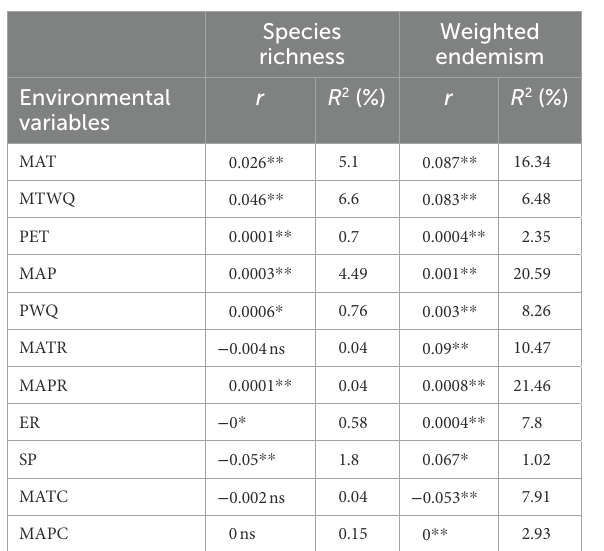
TABLE 1 Relationship between species richness/weighted endemism and each environmental variable identified using GLMs.